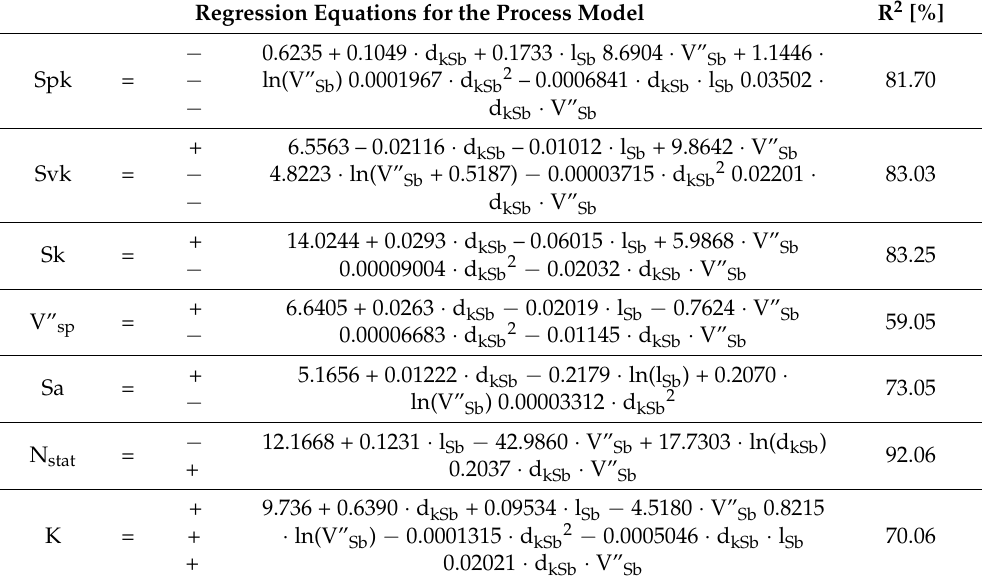
Table 4. Regression equation and model accuracy R 2 . Regression Equations for the Process Model R 2